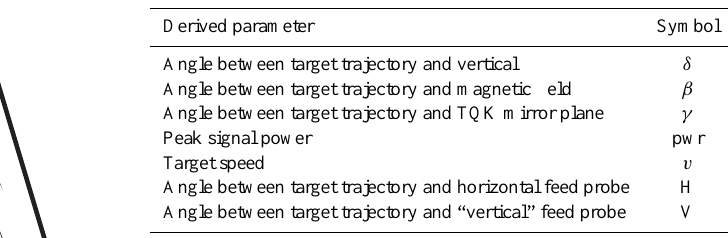
Table 1. Derived parameters and their